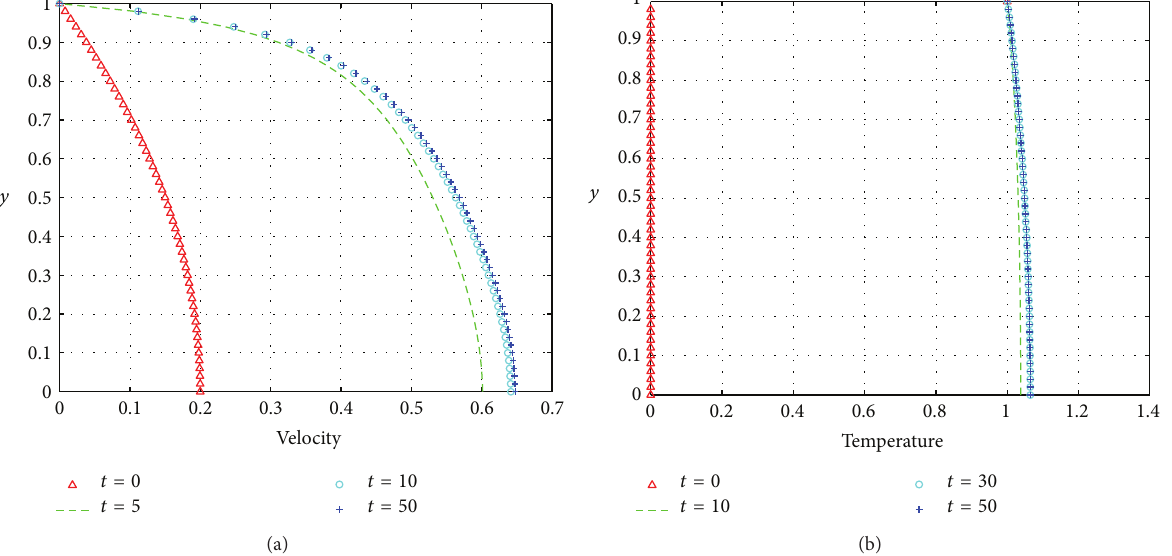
Figure 5: Developing velocity and temperature profiles.